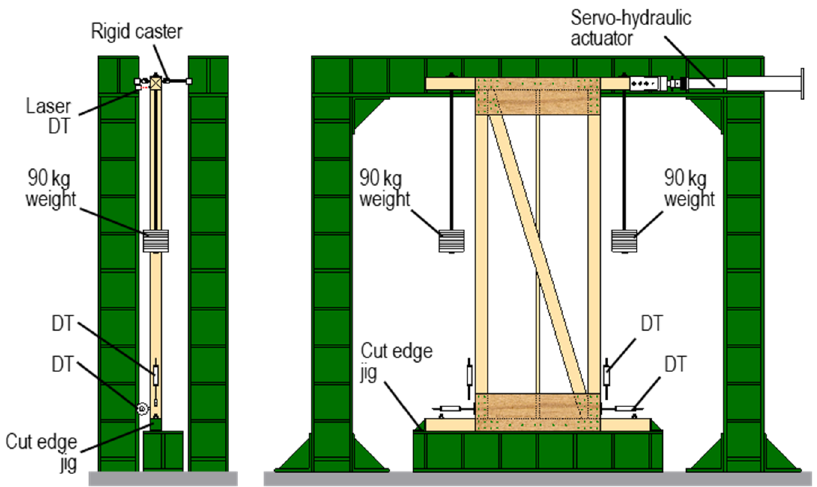
Figure 9. Test setup and instrumentation of full-scale in-plane cyclic test specimen.